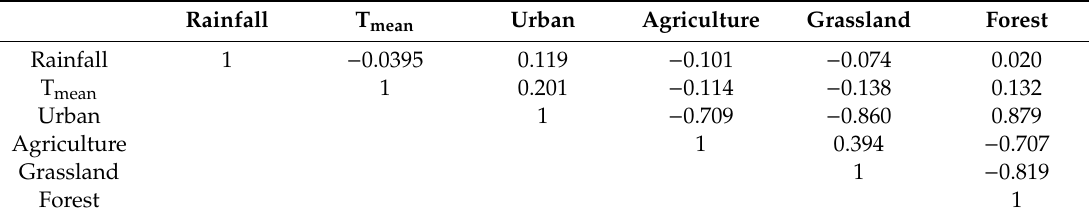
Table 13. Correlation matrix for the input parameters.